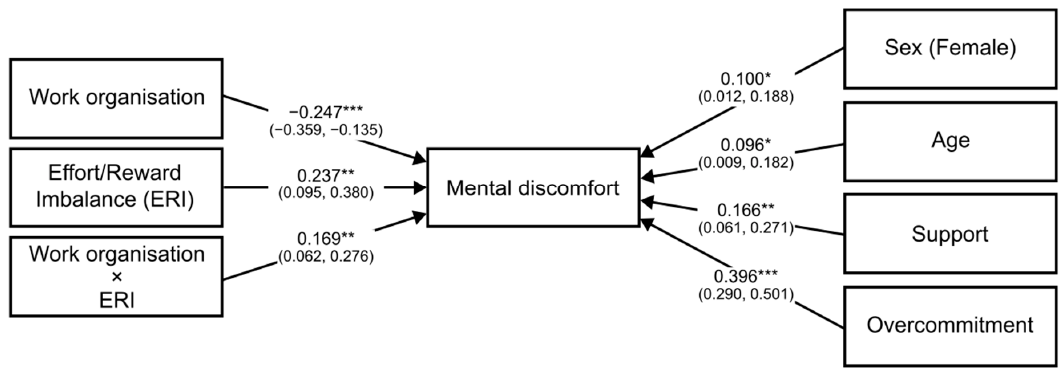
Figure 2. Diagram of the ERI model. Note: ***: p < 0.001; **: p < 0.01; *: p < 0.05.